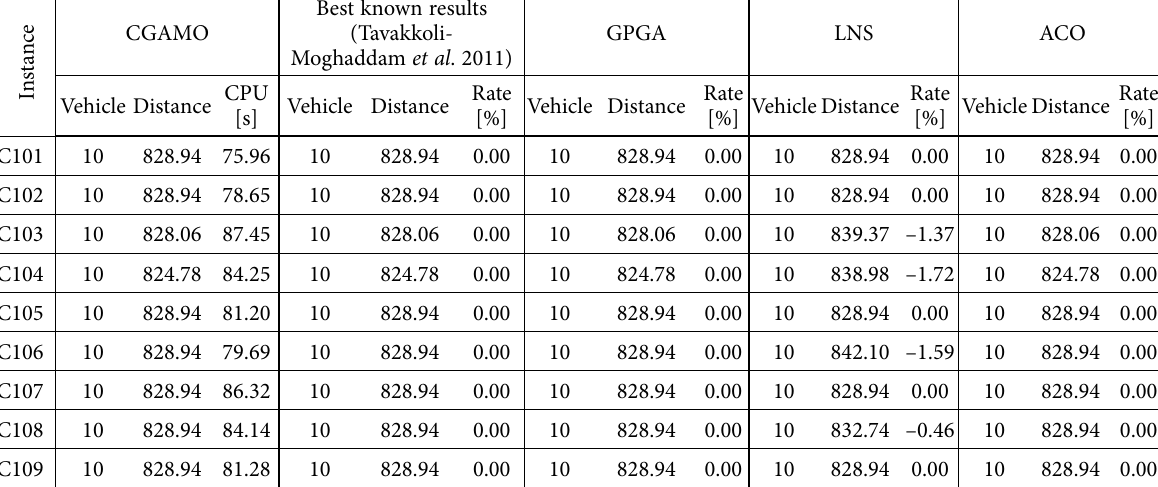
Table 3. Comparison results of different methods for VRPTW of